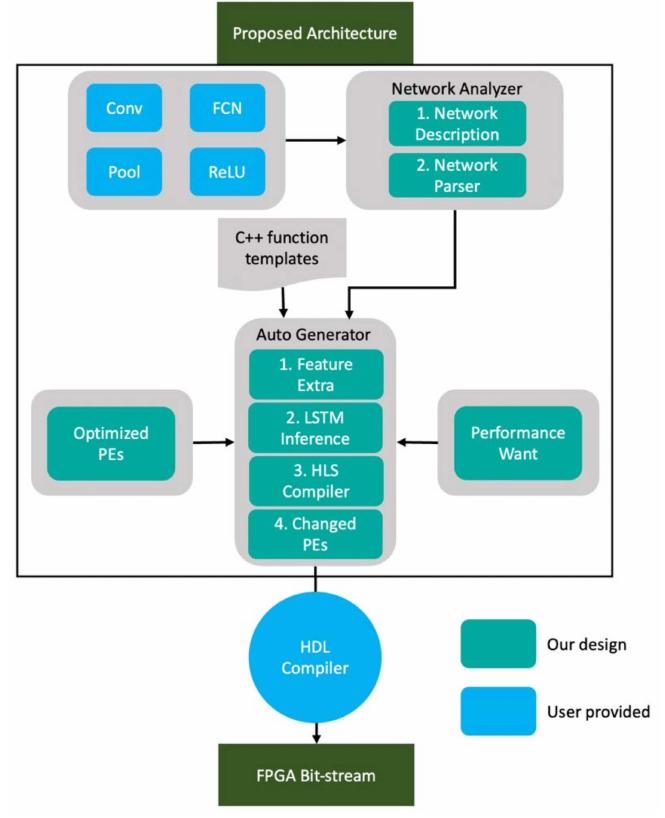
Figure 1. Proposed